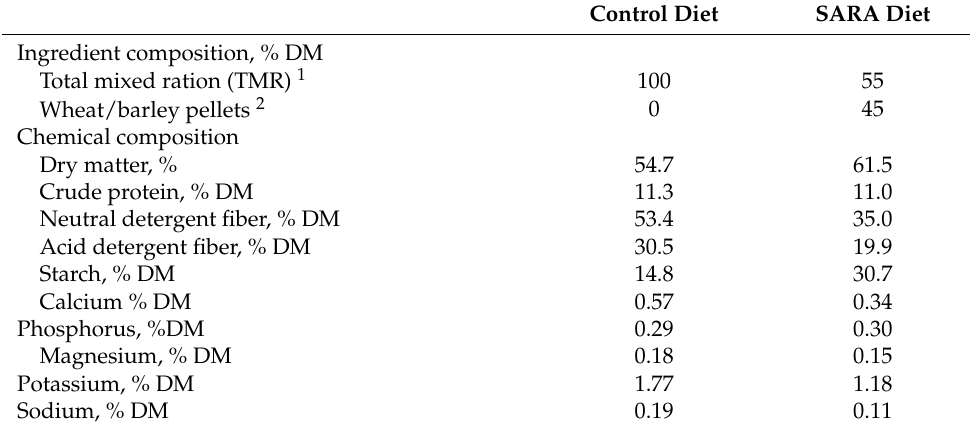
Table 1. Ingredient and chemical composition of the experimental